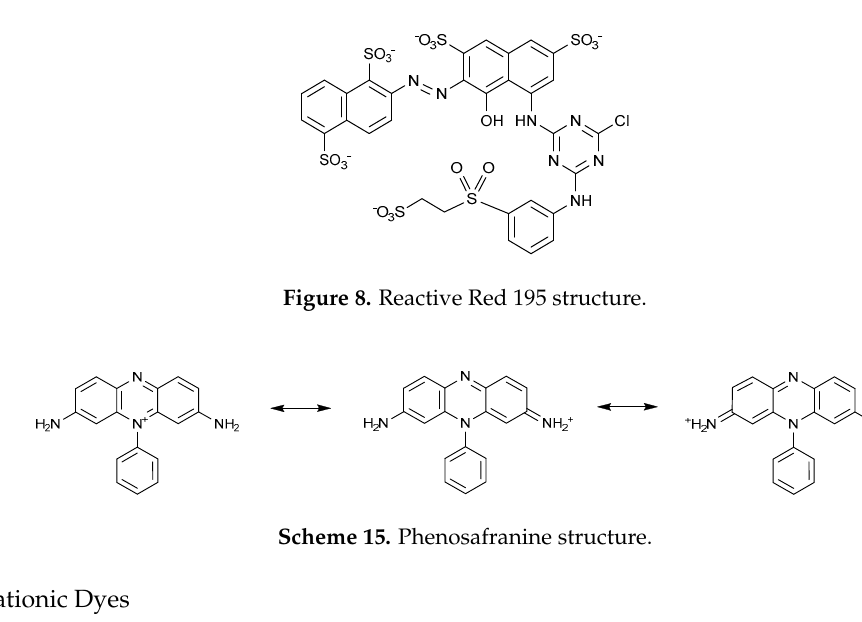
Scheme 15. Phenosafranine structure.